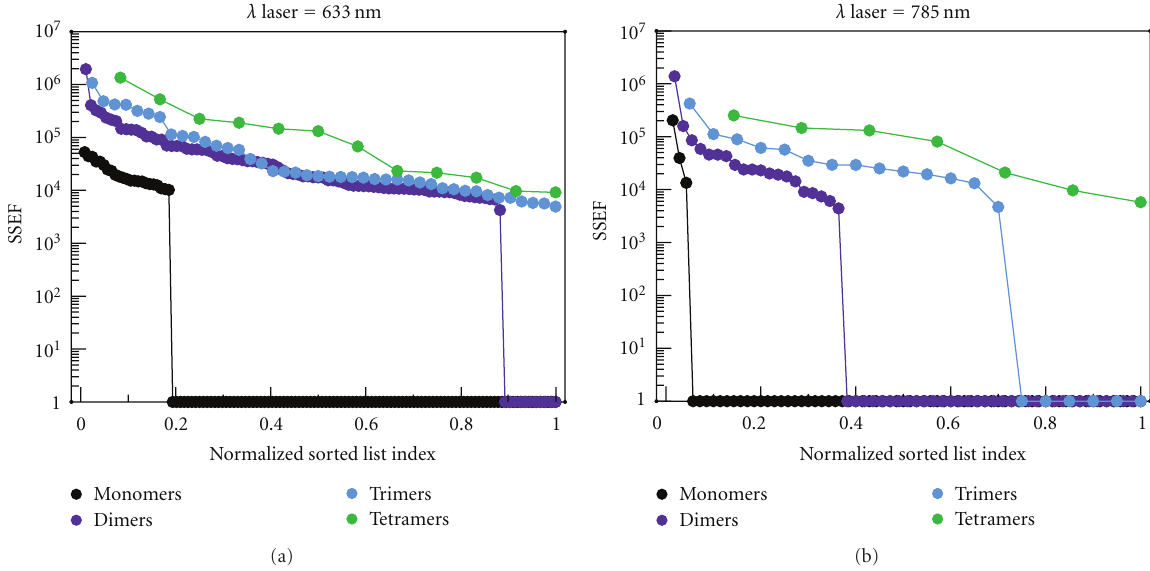
Figure 6: Cluster size analysis. Sorted SSEF data from silver nanocube monomers (black), dimers (violet), trimers (cyan), and tetramers (green). Excitation laser wavelength: (a) 633 nm and (b) 785 nm. Nanocube size: 110nm.